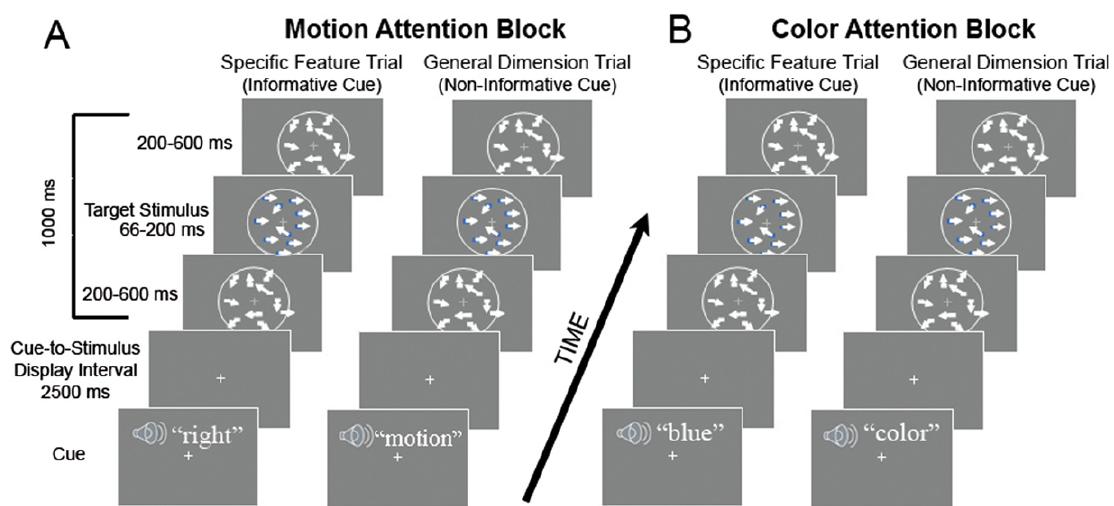
Figure 1. Schematic illustration of cue and stimulus trials for the motion and color conditions. (A) Stimulus sequence for the motion attention condition showing an informative specifi c feature cue trial (left in part A), where the cue (auditory word “right”) informed the subject of the motion of the upcoming target (if the trial contained any motion – see text). At right in part A, a non-informative general dimension cue trial is illustrated; here the subjects are presented only with the word “motion”, indicating that on that trial, if there is motion, it is equally likely to be left, right, up or down in direction. The cue, presented auditorily in a male voice, was followed by an interval of 2500 ms (cue-to-stimulus display interval, onset to onset) and then a display of randomly moving dots appeared for 1000 ms. In the midst of this presentation, there could be a motion target, where the dots briefl y move in a coherent direction – the same direction as was cued if there is motion on that trial. During the motion condition, there were also task-irrelevant color targets that could briefl y appear (see text for details). The plus ( + ) sign in the center of each panel is the fi xation point where subjects were required to maintain their gaze throughout each trial. Each trial was followed by an intertrial interval of 1000 ms. (B) Stimulus sequences for the color attention condition. Again the trial on the left of part B depicts an informative specifi c feature cue trial wherein subjects are cued to a specifi c color (e.g., blue). The right side of part B shows a non-informative general dimension trial. As in the motion attention condition, task-irrelevant coherent motion of the dots could also take place. Each trial lasted 4.5